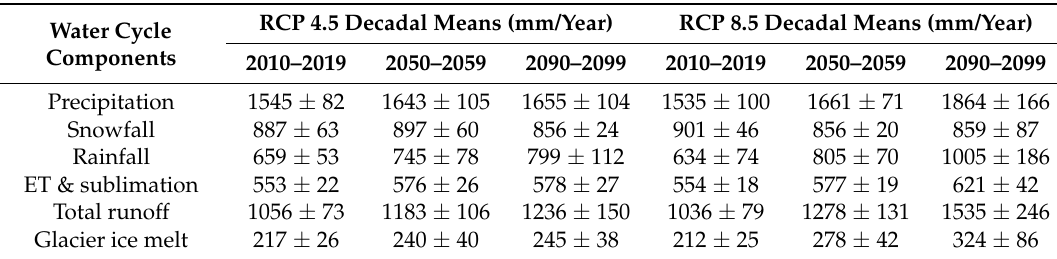
Table 4. Components of the water budget summarized by decade for RCP 4.5 and RCP 8.5. The values shown represent the five-model mean and the uncertainty represents the standard deviation of the five CMIP5 models.